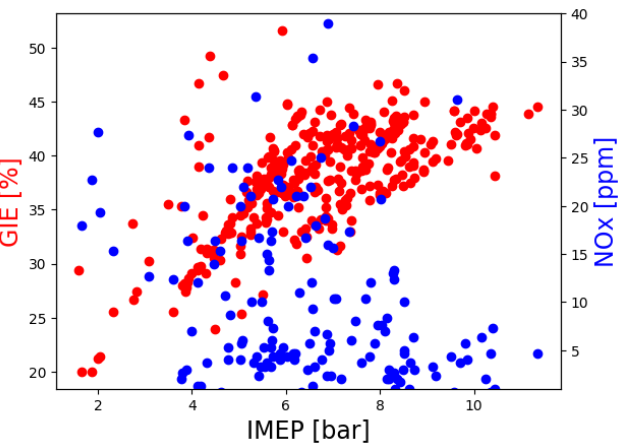
Figure 2. Experimental efficiency load map and NO x emissions test bench